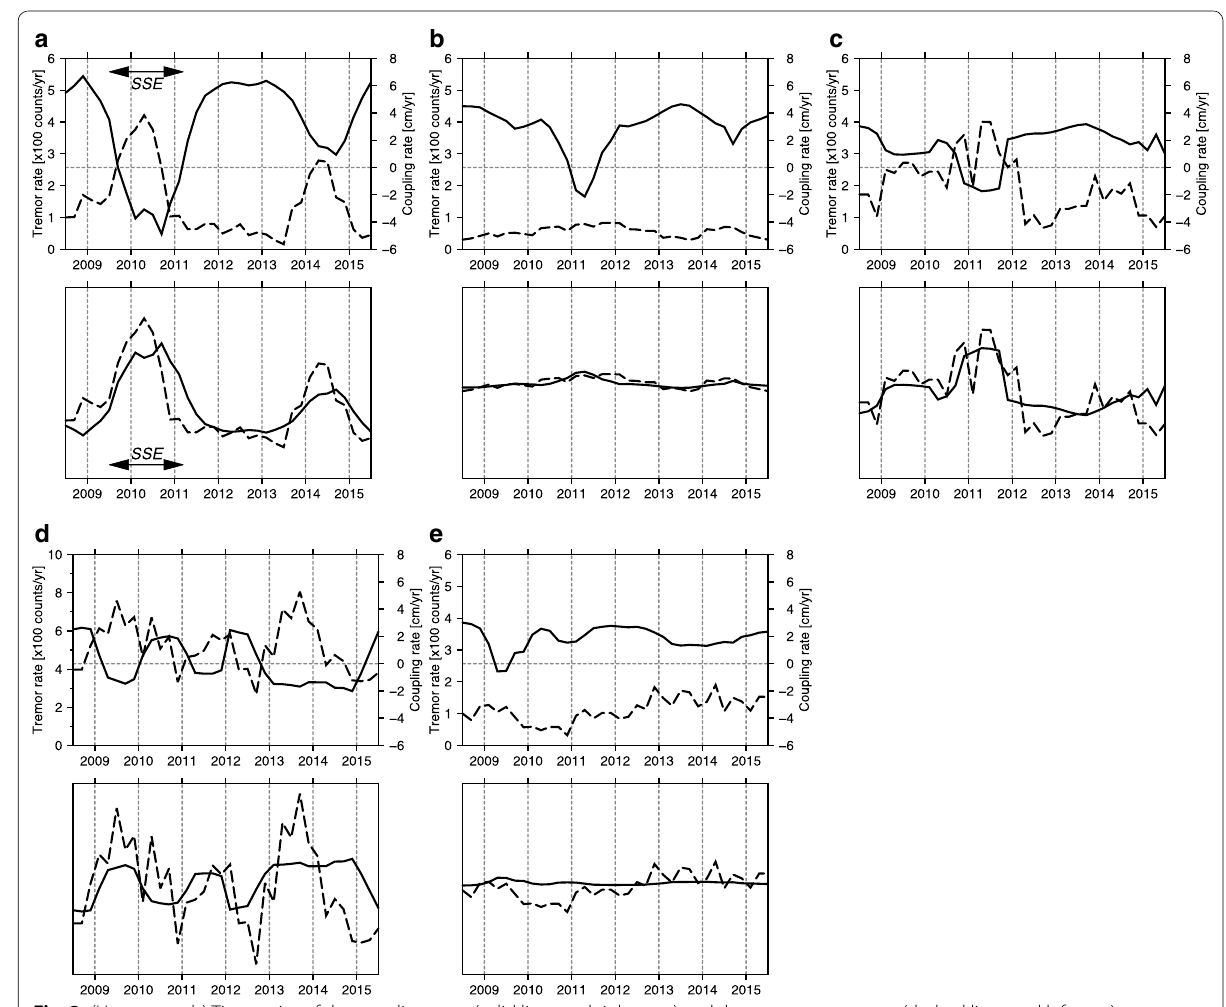
Fig. 3 (Upper panels) Time series of the coupling rates (solid lines and right axes) and the tremor count rates (dashed lines and left axes). a – e correspond to the values at grids (A)–(E) in Fig. 2. (Lower panels) Scaled time series of the coupling rates (solid lines) to fit the time series of the tremor count rates (dashed lines), which are identical to those that are depicted in the corresponding upper panels. The vertical scales are the same in the five upper panels, except for d , and in the five lower panels. “SSE” in a is the period of long-term SSE from 2009.5 to 2011.2, that was mentioned in Yoshioka et al.